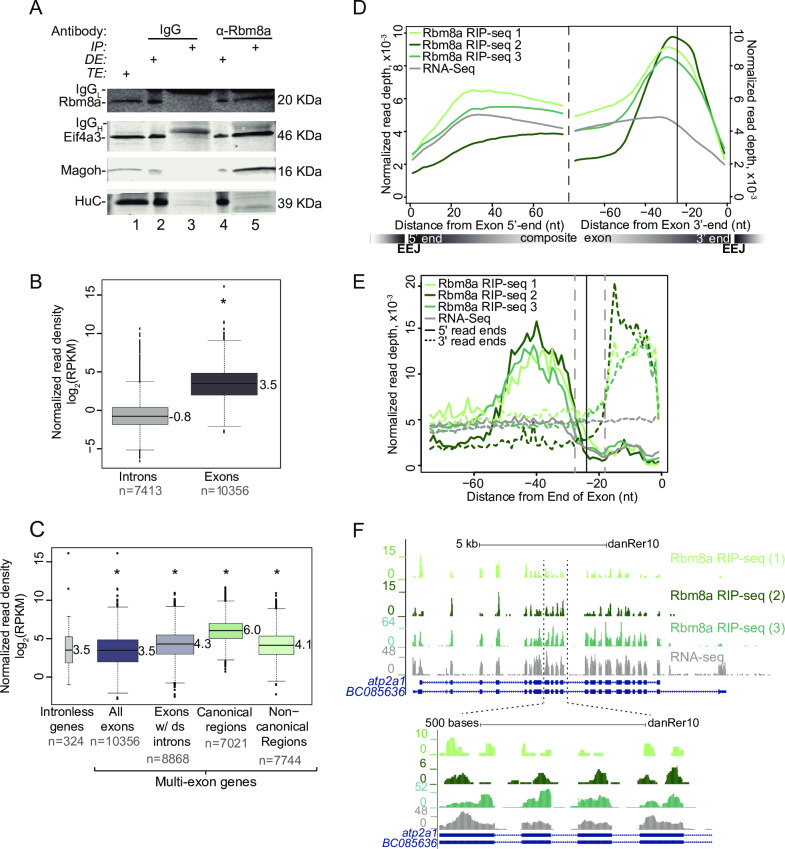
The zebrafish EJC is detected ~24 nucleotides upstream of exon-exon junctions.A. Western blot indicating Rbm8a, Eif4a3, Magoh and HuC proteins detected in RNase I-treated zebrafish embryo total extract (TE, lane 1), depleted extract (DE, lanes 2 and 4) immunoprecipitated protein complexes (IP, lanes 3 and 5). Antigens detected in the blot are listed on the left and antibodies used to immunoprecipitate complexes are listed on top. The signal corresponding to the antibody light chain and heavy chain in the IP lanes is indicated by IgGL and IgGH, respectively. B. Boxplots showing the Rbm8a RIP-Seq normalized read densities (reads per kilobase per million, RPKM) in intronic versus exonic genomic regions. Asterisk at the top indicates Wilcoxon test p-value, which is < 10−6. C. Boxplots as in B showing the Rbm8a RIP-Seq normalized read densities (RPKM) in the indicated genomic regions (bottom). Exons with downstream introns include all but last exons. Asterisk at the top indicates Wilcoxon test p-values, which are < 10−6. D. Meta-exon plots showing Rbm8a RIP-Seq and RNA-Seq (indicated on the top left) normalized read depths in a 75 nt region starting from the exon 5′ (left of dashed black line) or 3′ ends (right of dashed black line). Vertical black line: expected canonical EJC binding site (-24 nt) based on human studies. A composite exon with the relative position of exon-exon junctions (EEJ) is diagrammed at the bottom. E. A meta-exon plot of start and end of Rbm8a RIP-Seq or RNA-Seq reads (indicated on the top left; 5′ ends, solid lines; 3′ ends, dotted lines). Vertical black line: canonical EJC site (-24 nt). Gray vertical dashed lines represent boundaries of the minimal EJC occupied site. F. Top: UCSC genome browser screenshots showing read coverage along the atp2a1 gene in the Rbm8a RIP-Seq or RNA-Seq replicates as labeled on the right. Bottom: A zoomed in view of the region between the two dotted lines on the top panel. The y-axis on the left of each track shows maximal read coverage in the shown interval.